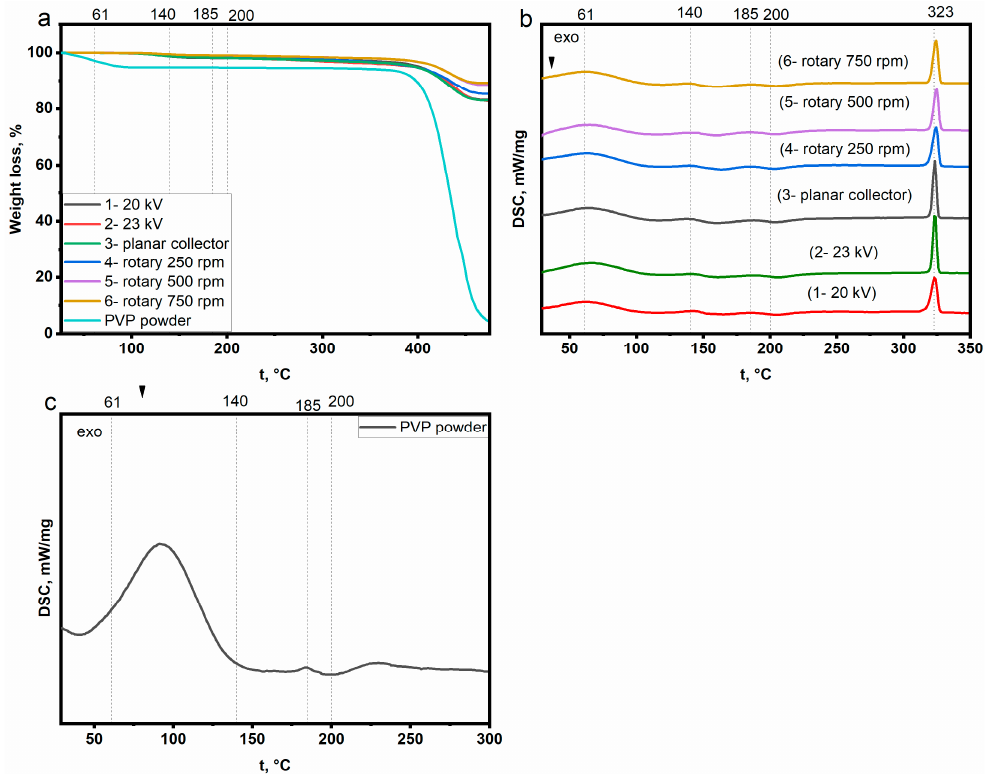
Figure 6. ( a ) TGA analysis; ( b , c ) DSC analysis. Samples were made according to the following parameters: Sample 1 (voltage: 20 kV, distance: 150 mm, needle diameter: 0.42 mm, feed rate: 0.1 mL/h, planar collector); Sample 2 (23 kV, 150 mm, 0.42 mm, 0.1 mL/h, planar collector); Sample 3 (20 kV, 150 mm, 0.72 mm, 0.3 mL/h, planar collector); Sample 4 (20 kV, 150 mm, 0.72 mm, 0.3 mL/h, rotary collector (250 rpm)); Sample 5 (20 kV, 150 mm, 0.72 mm, 0.3 mL/h, rotary collector (500 rpm)); Table 2. TGA results.